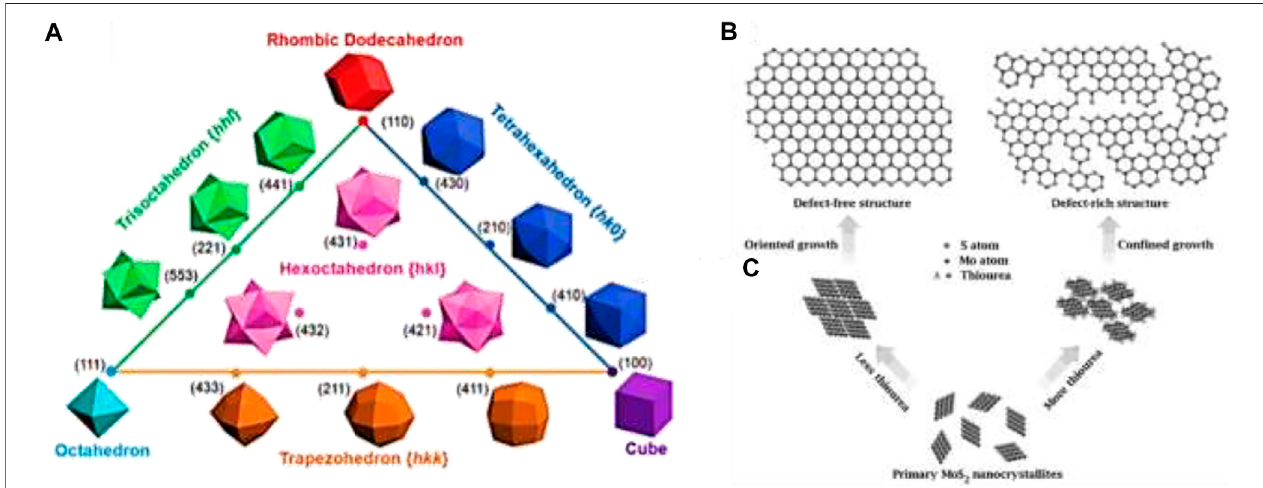
FIGURE4|(A) Triangular diagramshowingfccmetalpolyhedrons boundedbydifferentcrystallographicfacets.Reprinted (adapted)withpermission fromYuetal. (2010). Copyright (2010) American Chemical Society. (B) Structural models of defect-free and defect-rich structures. (C) Synthetic pathways to obtain the above two structures. Adapted with permission from Xie et al.